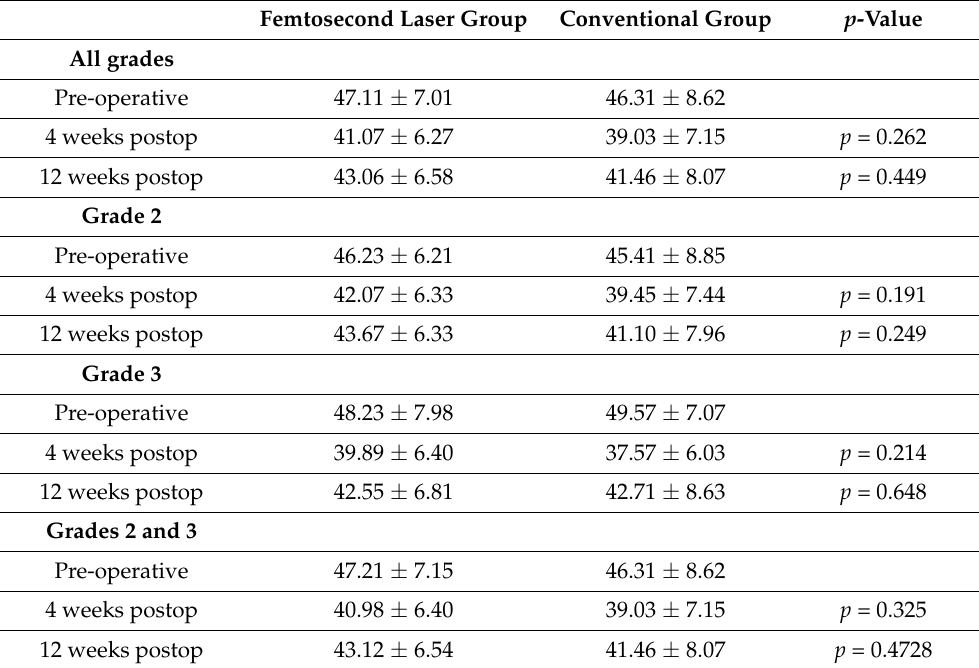
Table 4. Comparison of the mean value of the percentage of hexagonal cells (6A) in % between the femtosecond laser and conventional group over time, for all eyes and split into subgroups. Femtosecond Laser Group Conventional